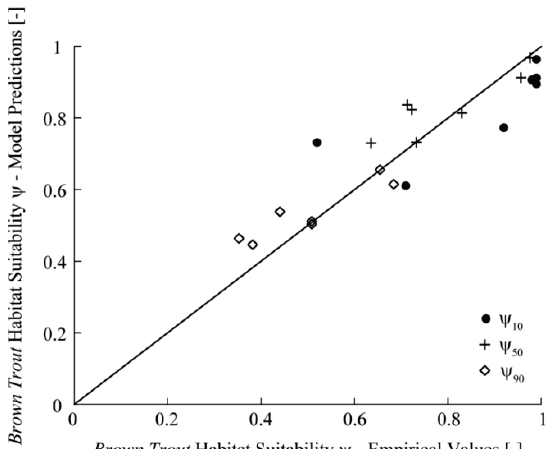
Fig. 3 Brown trout habitat suitability: scatterplot of 0.1-, 0.5-, 0.9-quantiles of empirical values (derived from water depth values) against model predictions from cross-validation (equations (2) and